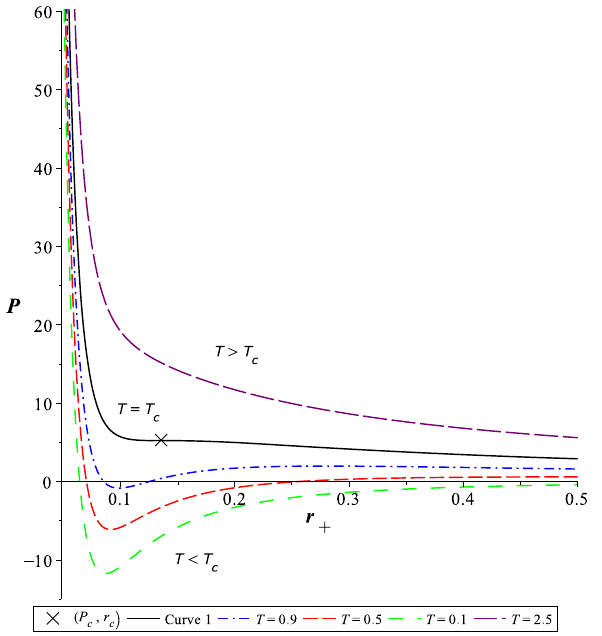
Fig. 2 P − r + diagram in the seven-dimensional case, for σ = 10 − 2